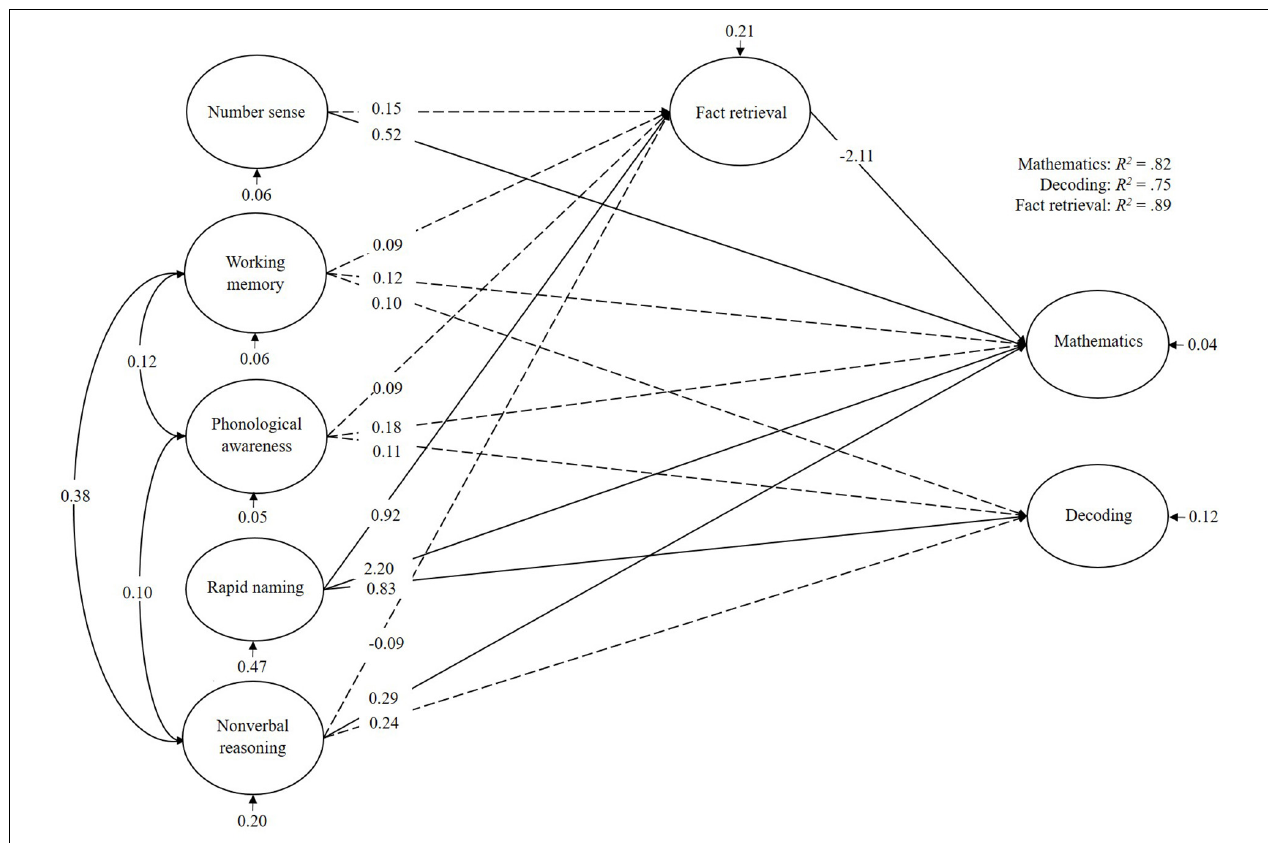
FIGURE 4 | Bayesian structural equation model for children with weak decoding abilities (RLD). Denoted values are beta